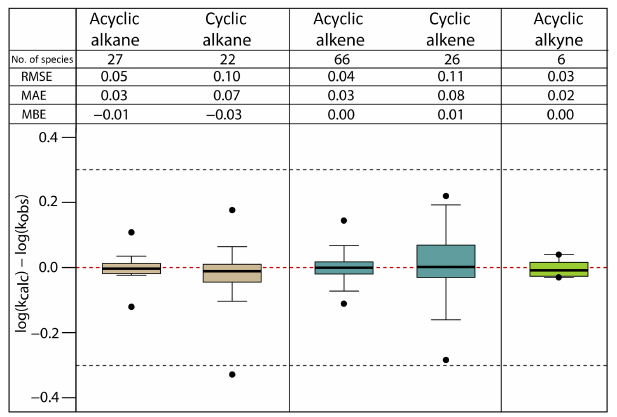
Figure 9. Root mean square error (RMSE), mean absolute error (MAE), mean bias error (MBE) and box plot for the error dis- tribution in the estimated log k 298K values for various subsets of aliphatic hydrocarbons. The bottom and the top of the box are the 25th ( Q 1 ) and 75th percentiles ( Q 3 ), the black band is the median value. The whiskers extend to the most extreme data point which is no more than 1.5 × ( Q 3 – Q 1 ) from the box. The points are the extrema of the distribution. The black dotted lines correspond to agreement within a factor 2.